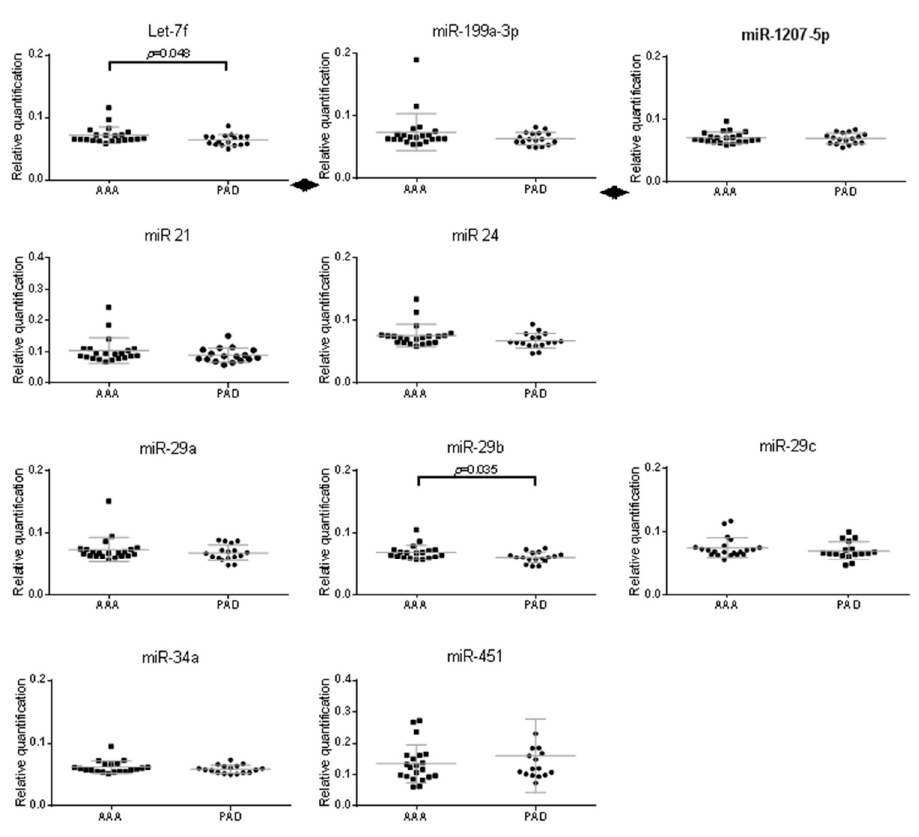
AAA: aortic abdominal aneurysm, PAD: peripheral arterial disease.